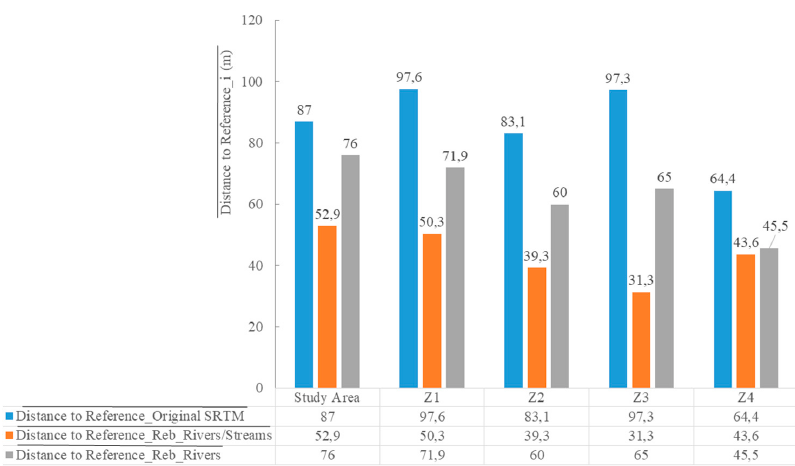
Figure 20. Graph showing the variation of the mean horizontal distance between the reference drainage network and the drainage network obtained from the original SRTM 30, and the rebuilt DEM using OSM rivers and streams and only